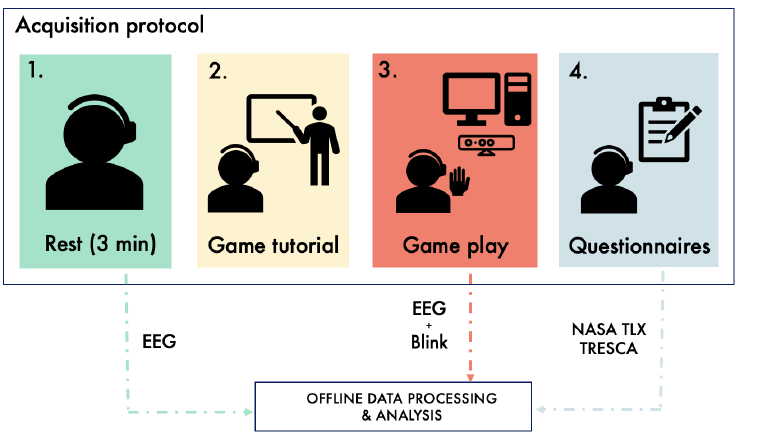
Figure 1. Experimental data acquisition protocol: an EEG baseline is computed from a 3-min resting phase, then the subject is instructed about the game, plays the game and finally answers the NASA and TRESCA